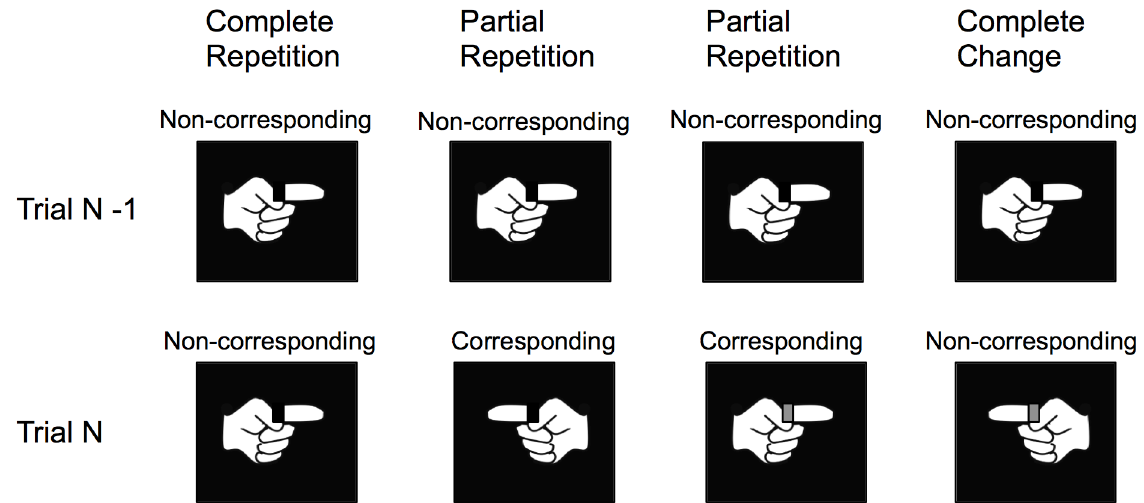
Fig 3. The relations between stimuli and responses occurring in adjecent trials is illustrated here assuming left-hand responses to dark targets and right-hand responses to light targets. In the example shown here, stimuli and responses were always non-corresponding in the preceding trial (N-1). Stimuli and responses in the next trials (N) were either repeated—completely or in part—or changed entirely.